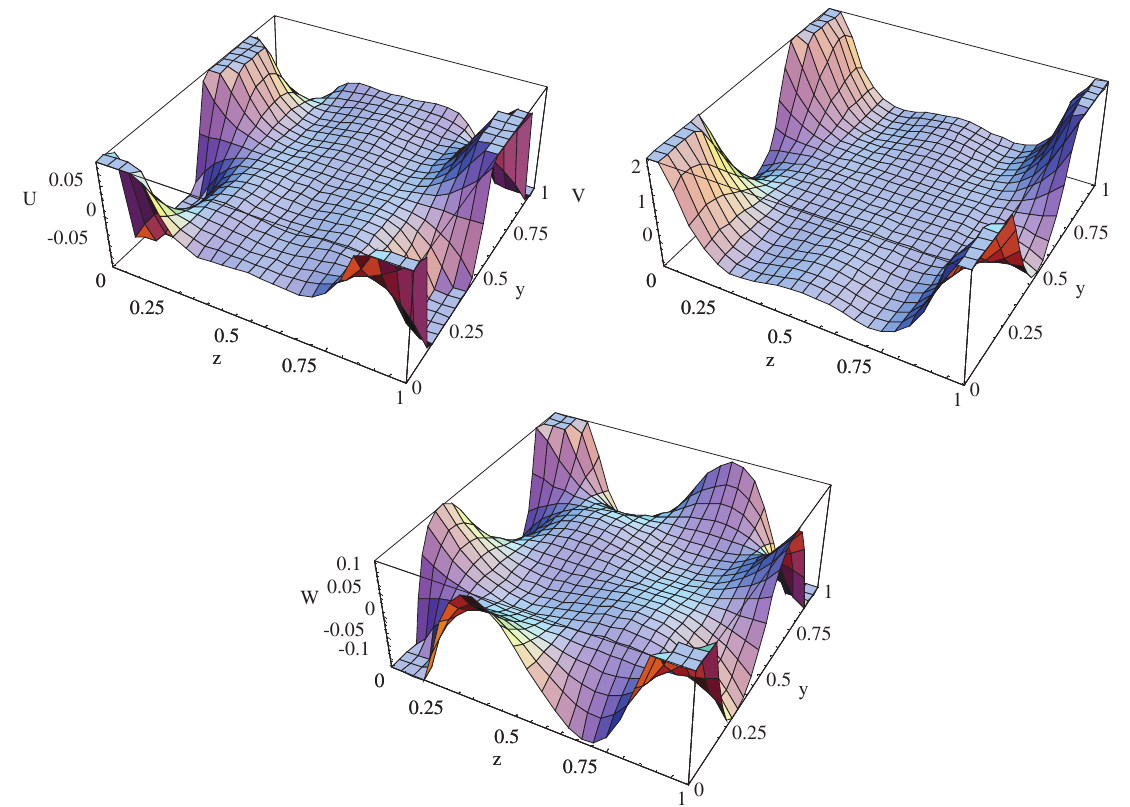
Figure 7: Displacement shapes of the first mode for the sinusoidally FGPP square bar at kd =